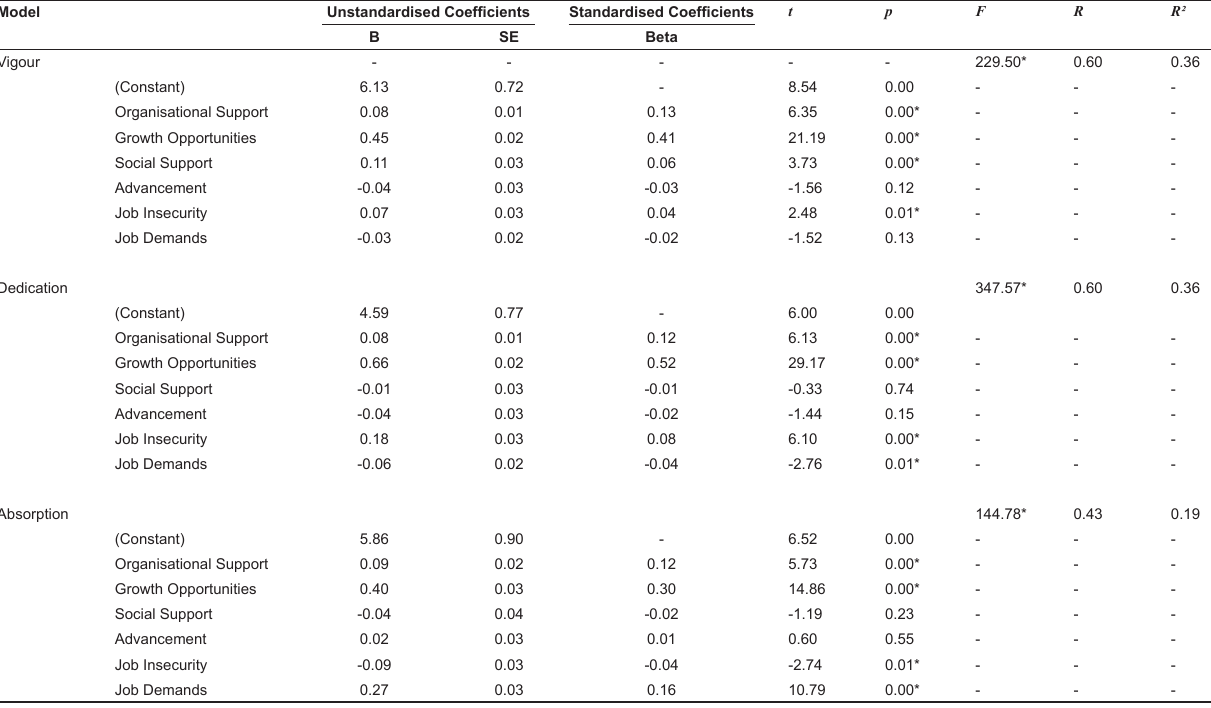
TABLE 8 Regression analyses of psychological conditions and antecedent factors as independent variables on employee engagement as dependent